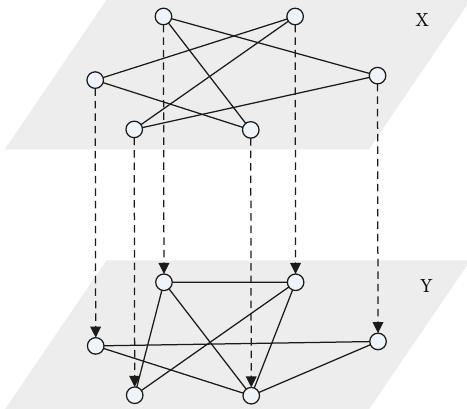
Figure 1: A two-layer network with unidirectional interlayer cou-